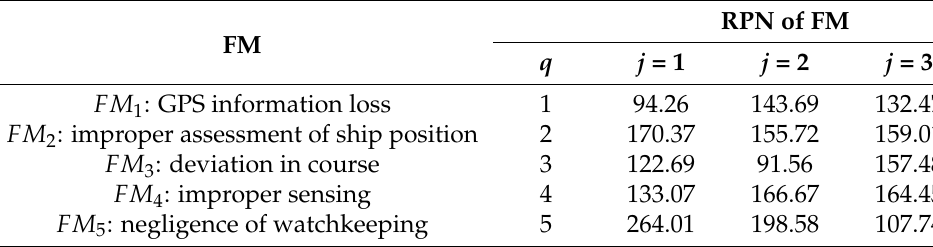
Table 8. RPNs of five FMs in three operational